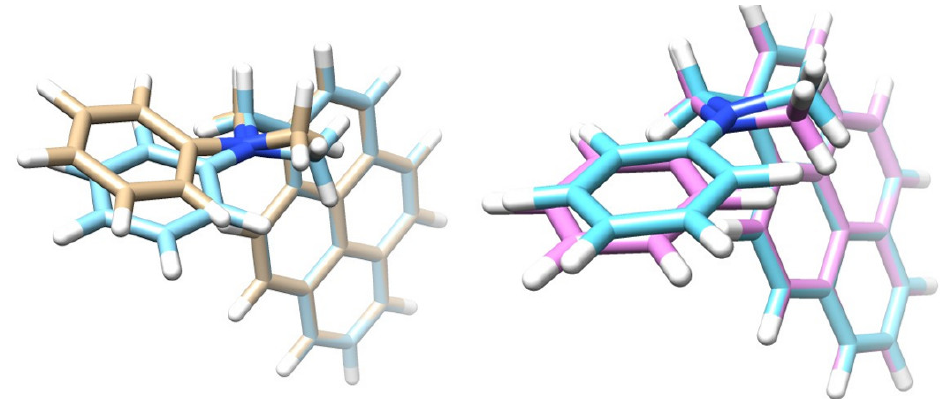
Figure 4. Left : A comparison between the optimized molecular structures of the ground state (in blue) and the S 1 state (in brown). Right : A comparison between the S 1 (= 1 CT, in blue) and the T 2 (= 3 CT) state (in pink). (PBE/TZP).